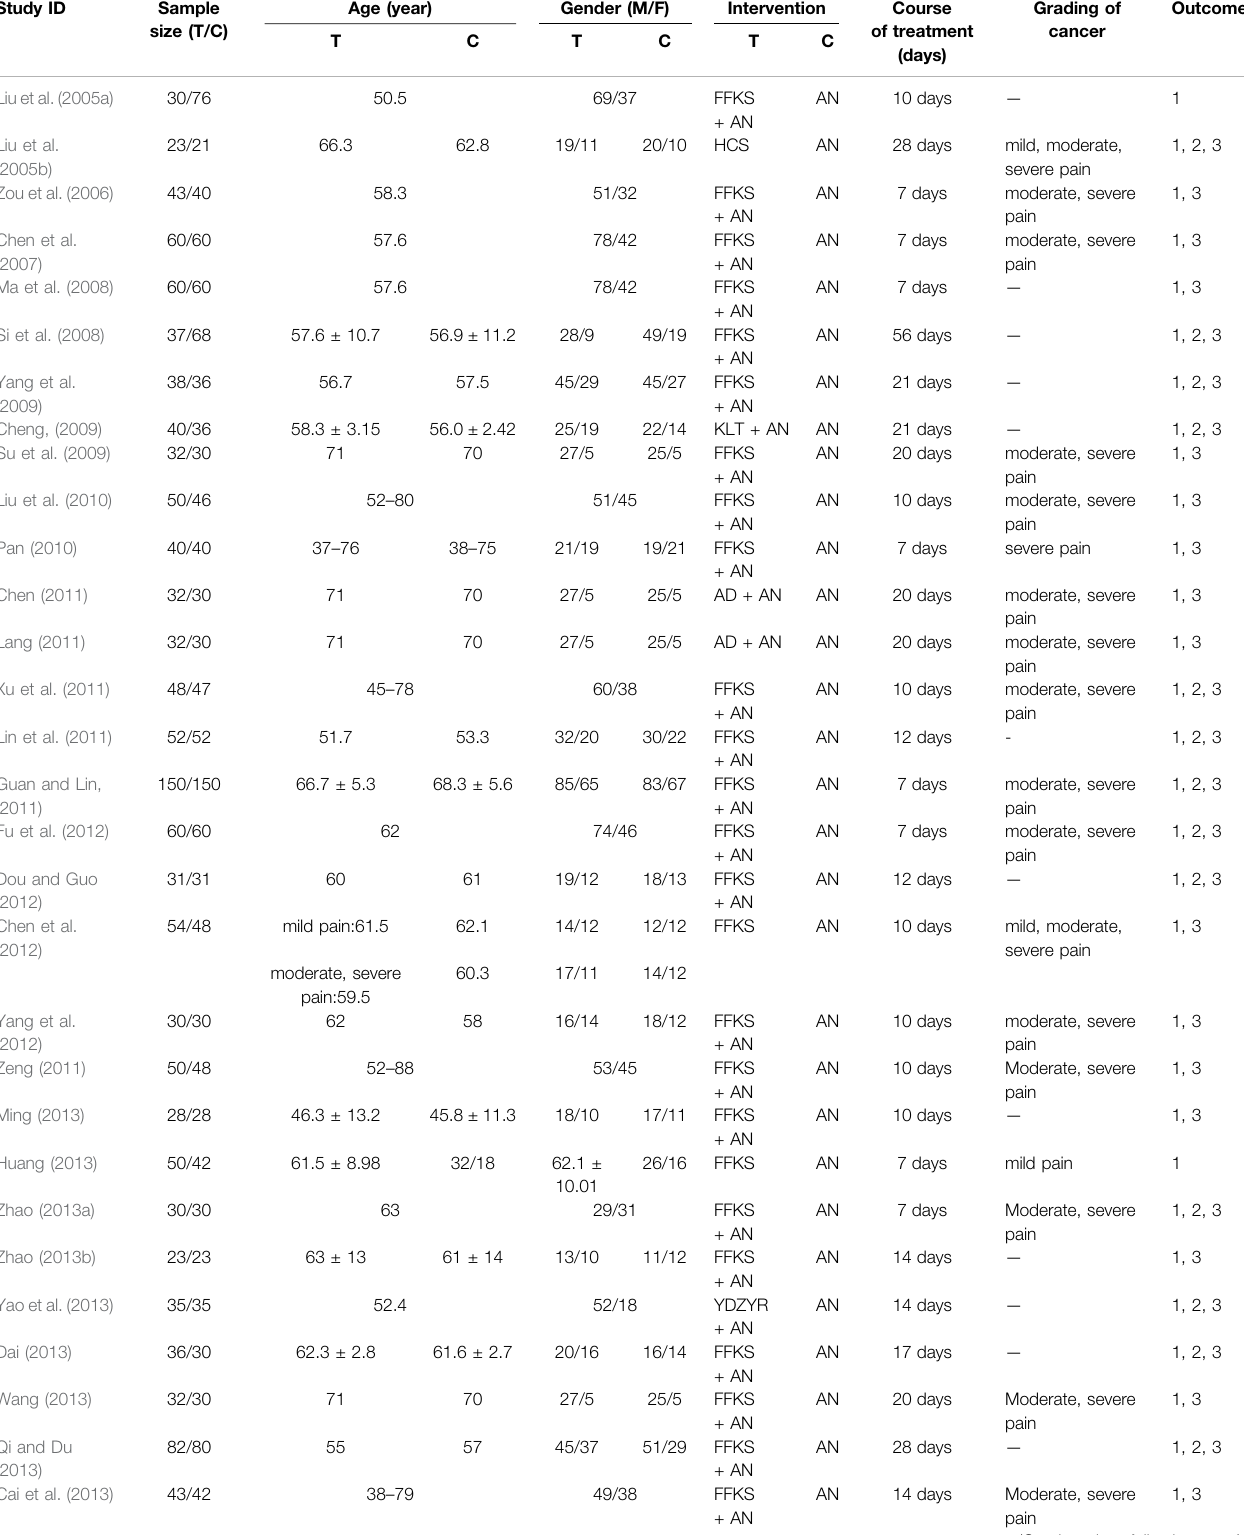
TABLE 1 | Characteristics of the included randomized controlled